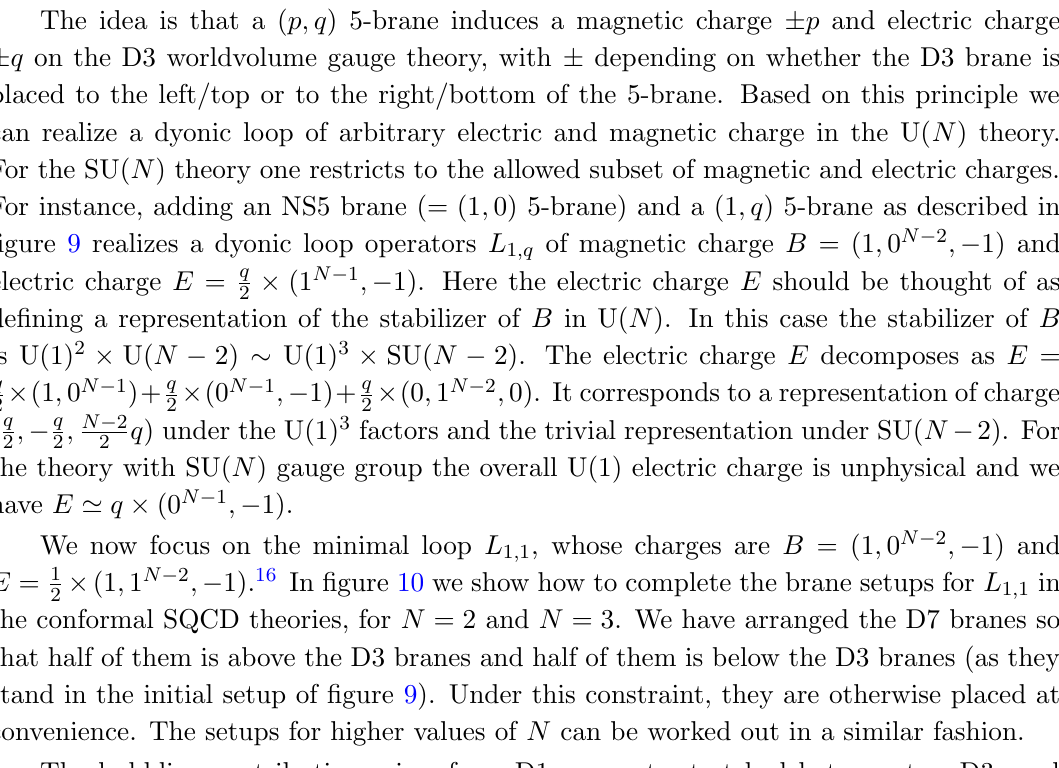
the presence of a magnetic loop (’t Hooft loop) is related to adding NS5 branes and that the presence of an electric loop (Wilson loop) is related to adding D5 branes. Here we propose that dyonic loops are related to the presence of ( p; q ) 5-branes.